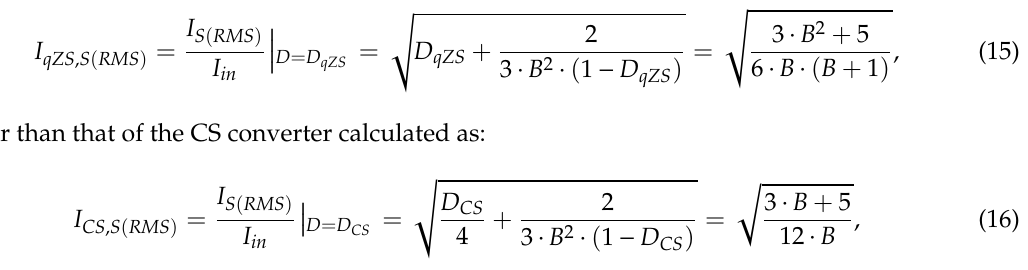
Figure 13. Normalized peak current of the transformer input winding as a function of the input voltage boost factor B .